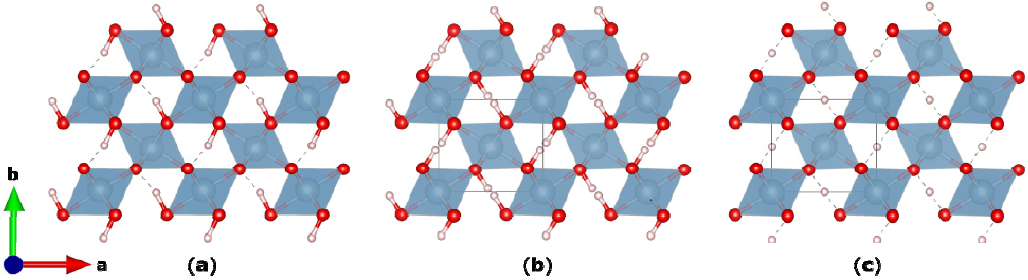
Figure 1. Crystal structure of δ -AlOOH shown in the projection along the c direction at the ambient pressure space group P 2 1 nm ( a ) and at the high symmetry phase Pnnm, featuring disordered hydrogen in the intermediate phase between 9 and 18 GPa ( b ) and symmetric hydrogen above 18 GPa ( c ).